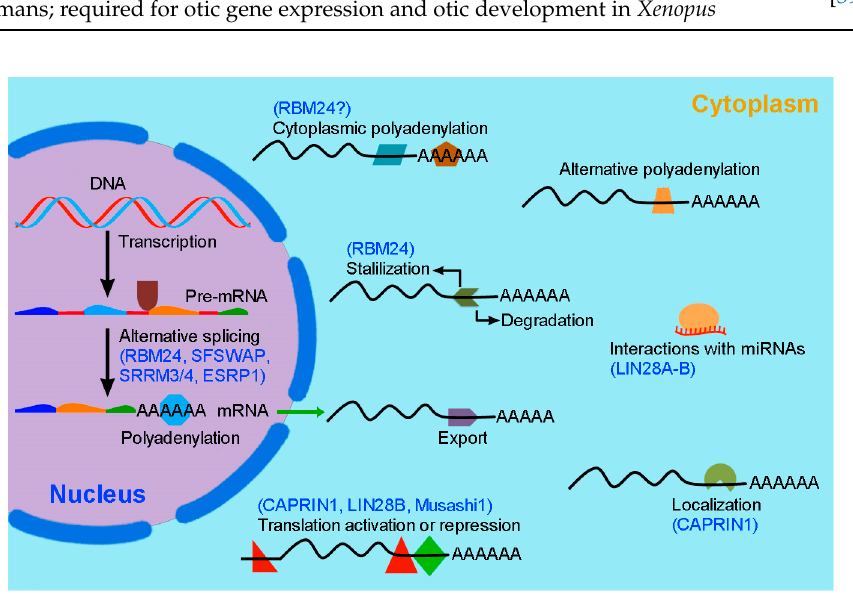
Figure 1. Illustration of RBP-mediated post-transcriptional regulation of gene expression. Following transcription, RBPs (colored forms) interact with pre-mRNAs, mRNAs, or miRNAs to regulate alternative splicing, polyadenylation, export, localization, stability/degradation, and translation. Shown are several RBPs with known post-transcriptional regulatory functions during inner ear development and regeneration. Note that LIN28A-B can inhibit the biogenesis of let7 miRNA and that CAPRIN1 can sequester mRNAs into stress granules to prevent their translation. Table 1. RBPs in inner ear hair cell development, regeneration, and function.